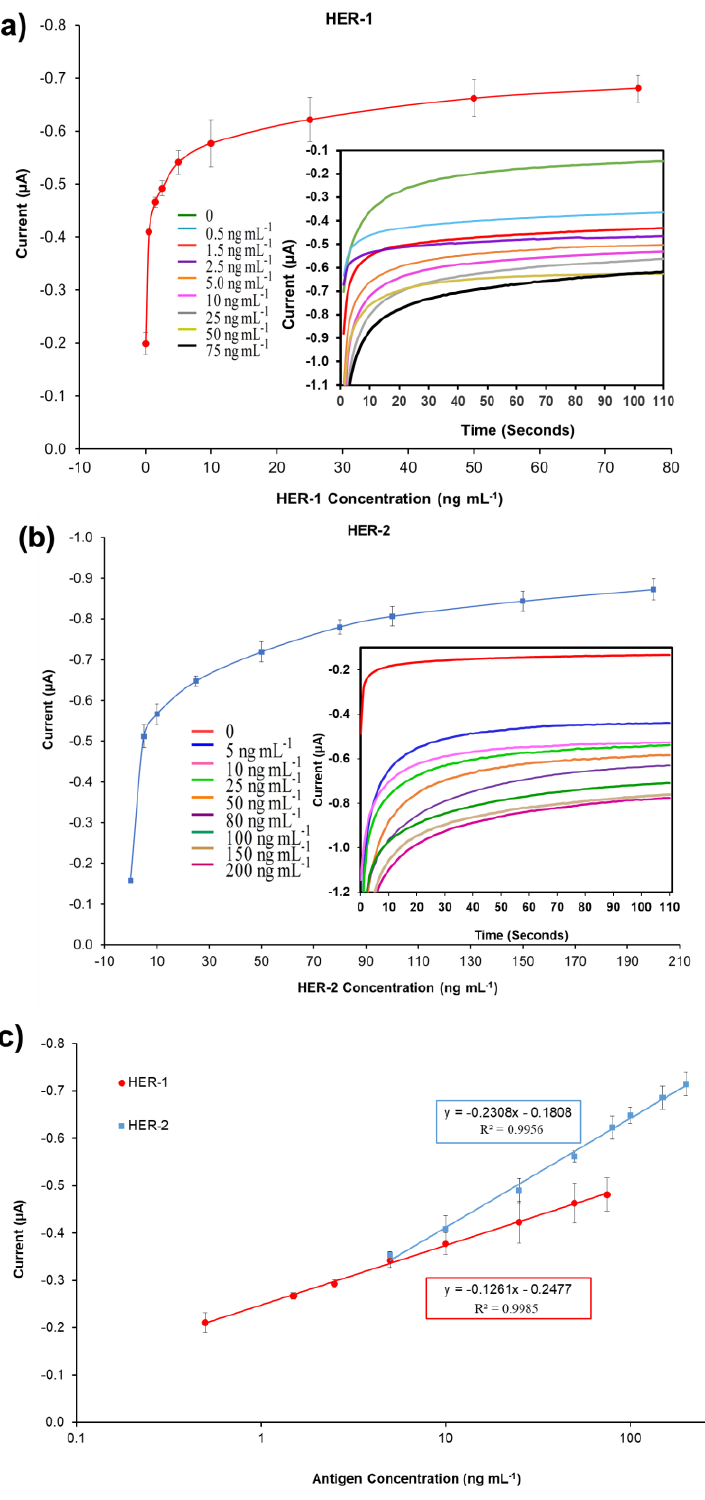
Figure 2. Biosensors responses of the optimized immunoassays against various concentrations of; ( a ) HER-1 antigen (0.5 – 75 ng mL −1 ); ( b ) HER-2 antigen (5 – 200 ng mL −1 ). Measurements were taken after 110 s at a potential of −200 mV. Embedded graphs show the raw data obtained. ( c ) Linear regression of the HER-1 and HER-2 assay, obtained with data taken from Figure 2a,b. Standard deviations were calculated for experiments performed in triplicate( n = 3).